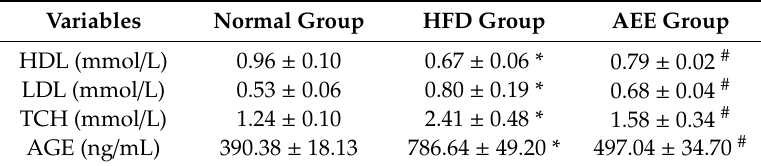
Table 1. The effects of AEE on serum biochemical indices and AGE levels. Variables Table 1. The e ff ects of AEE on serum biochemical indices and AGE levels. Variables